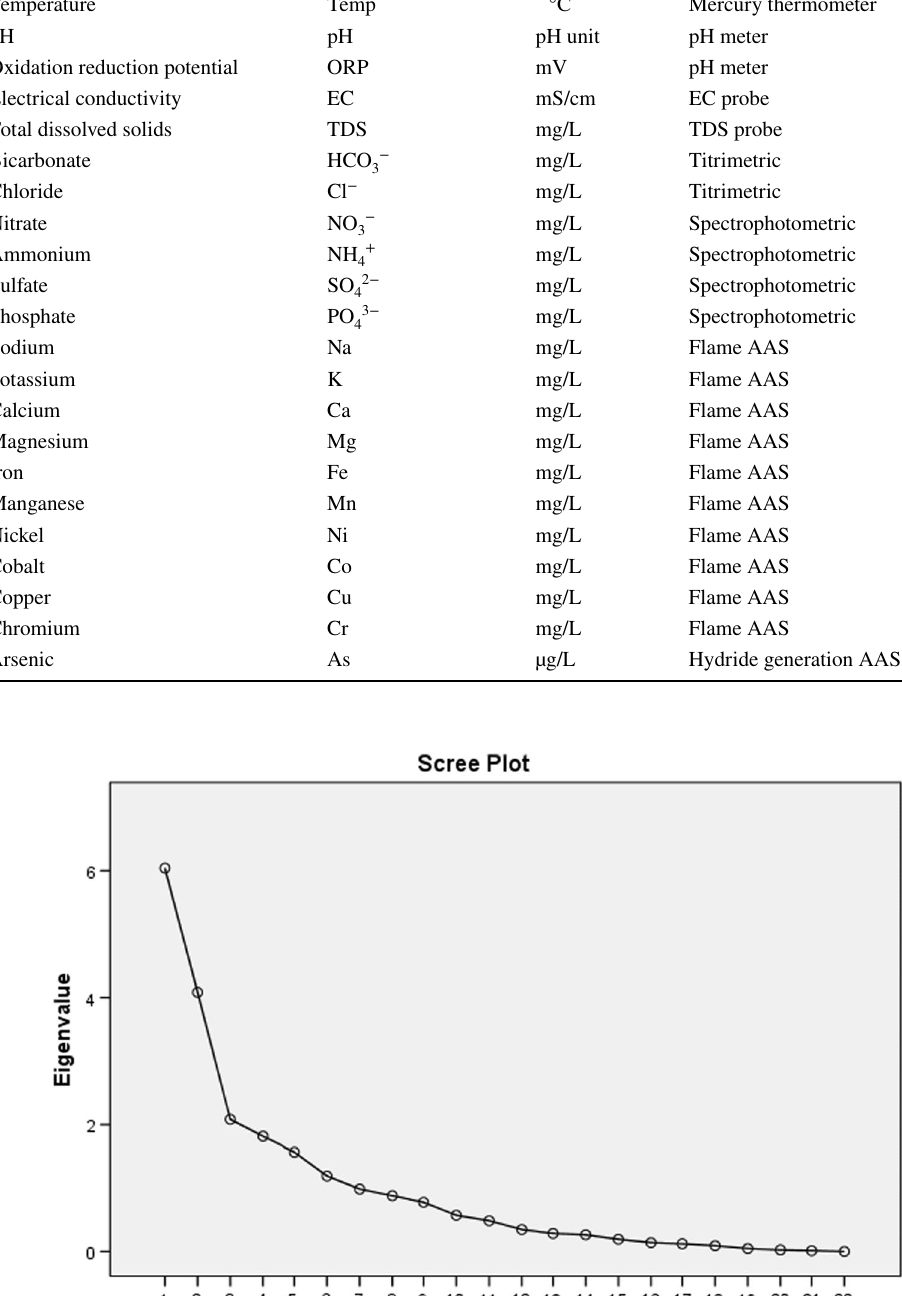
Table 3 Major water quality characteristics, abbreviations, units and determination